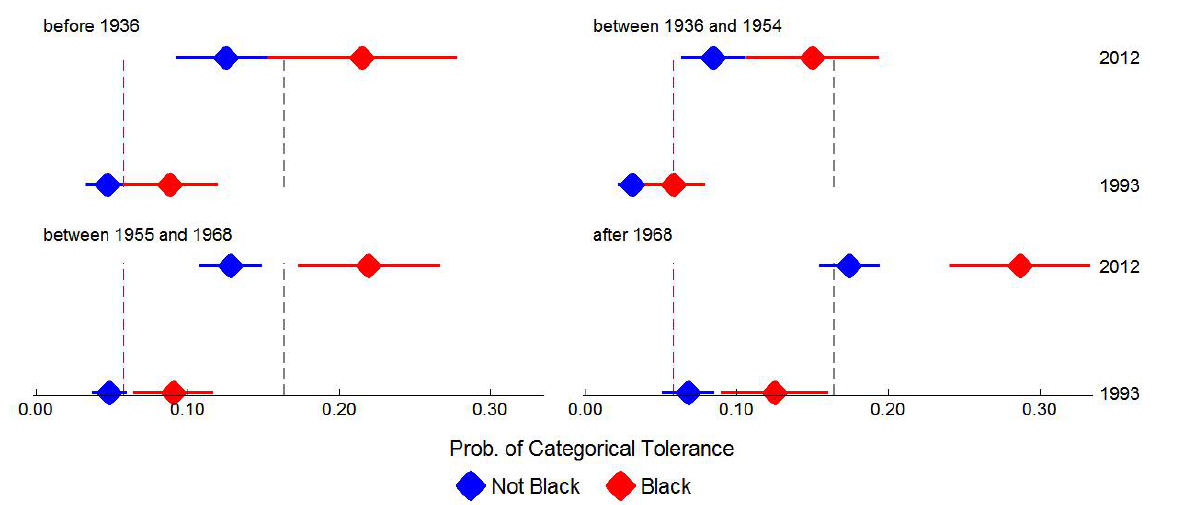
Figure 3: Predicted probability of being a categorical tolerant from binary component of the preferred zero- inflated Poisson specification by cohort group and ethnoracial status. Dashed vertical lines indicate sample estimates from proportion of the population with zero dislikes in 1993 (red dashes) and 2012 (gray